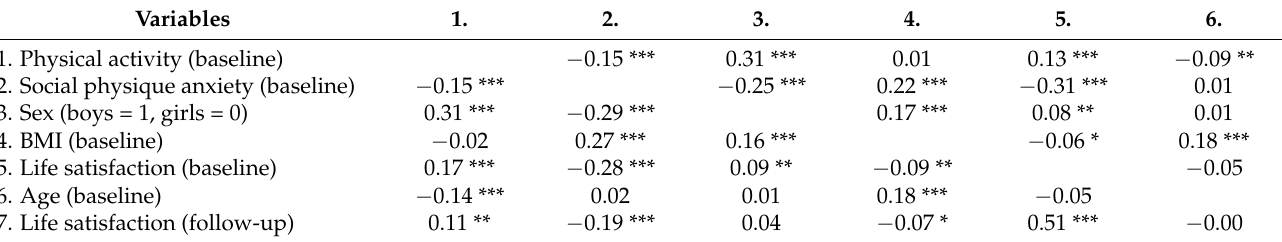
Table 2. Bivariate correlations (Pearson, two-tailed) between study